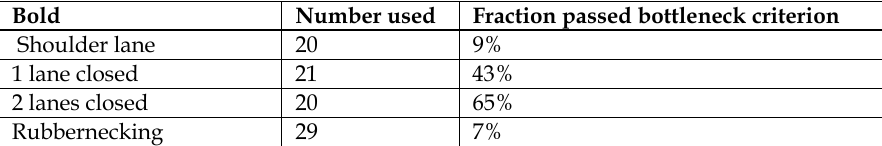
Table 3. Fraction of incidents